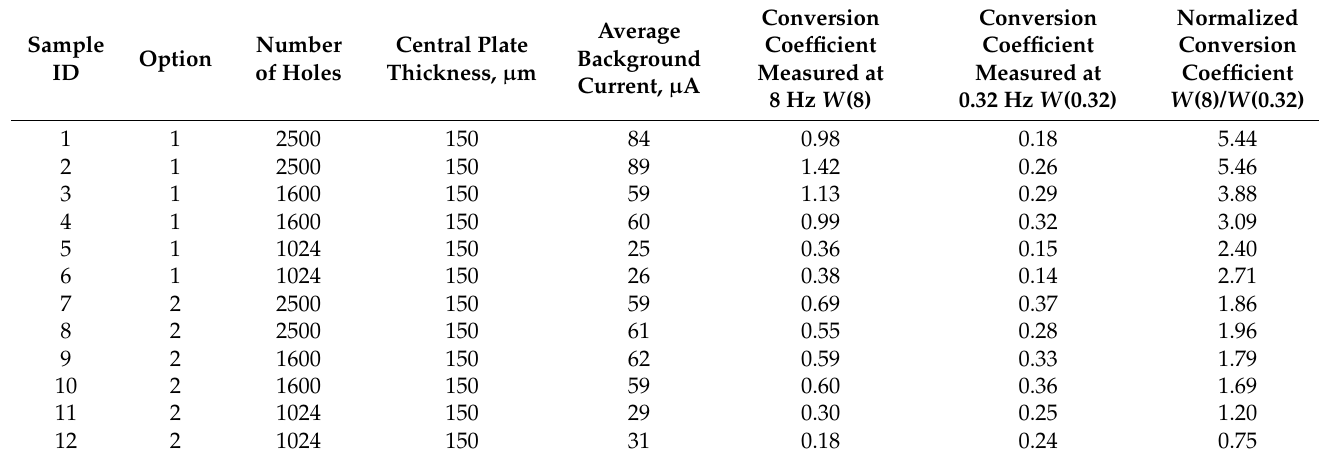
Table 1. Summarized parameters and of the experimental